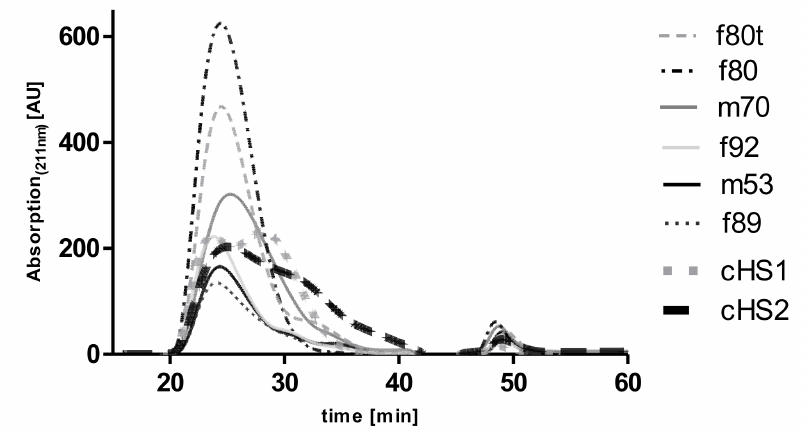
Figure 2. Size exclusion chromatogram of the different HS isolates from donor lungs (f80t, f80, m70, f92, m53, f89). Samples starting with f are from female patients, and those with m are from male, with the number depicting the age of the lung and the t identifying tumor lobe. Chromatograms are compared with two commercially available porcine-derived HS (cHS1 and cHS2). Data were recorded using a diode array detector, but the absorption maximum at 211 nm was used for the HS preparations and standards because of the highest sensitivity at this wavelength. The AUC of the HS preparations of the m53 and f89 differ significantly from the preparations of the other samples because different amounts of process-related impurities are expected to contribute to the absorption of the samples at 211 nm. Table 2. Molar HS disaccharide percentage range found in five different human lung isolates compared with murine lung HS and commercially porcine-derived HS. All preparations were prepared thrice, and the disaccharide composition percentage range is listed. With f for females, m for males, and the number for the patient’s age, n.d. for not detected. m53 m70 f80 f89